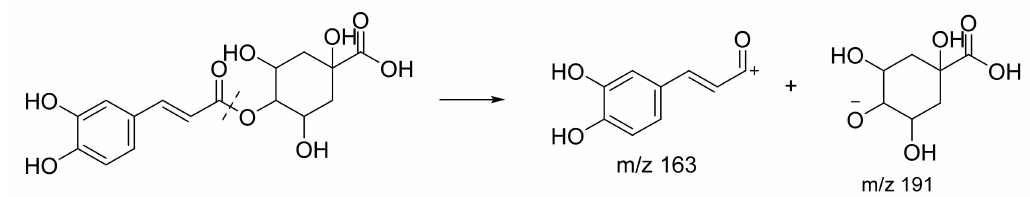
Figure 4. Proposed fragmentation pathway for 4-[[3-(3,4-dihydroxyphenyl)-1-oxo-2-propenyl]oxy]-1,3,5-trihydroxycy clohexanecarboxylic acid.